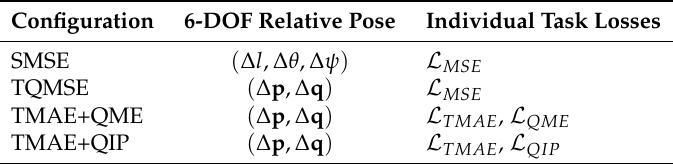
Table 3. Evaluation configuration for 6-DOF relative pose representation and individual task losses: spherical coordinates + mean squared error (SMSE), translation and quaternion + mean squared error (TQMSE), translation mean absolute error + quaternion multiplicative error (TMAE+QME) and translation mean absolute error + quaternion inner product